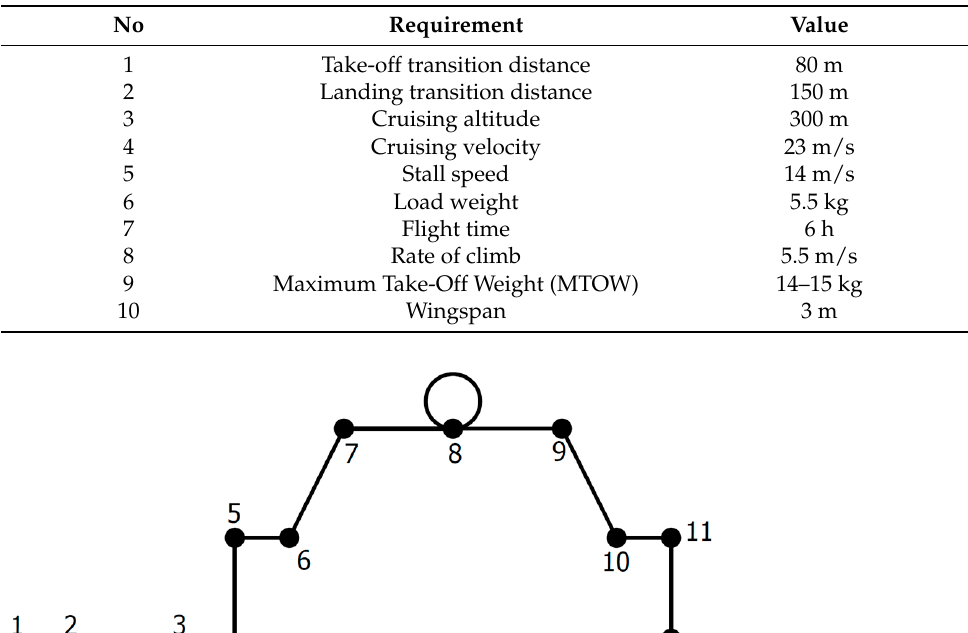
Table 1. Design Requirements and Objective (DRO).